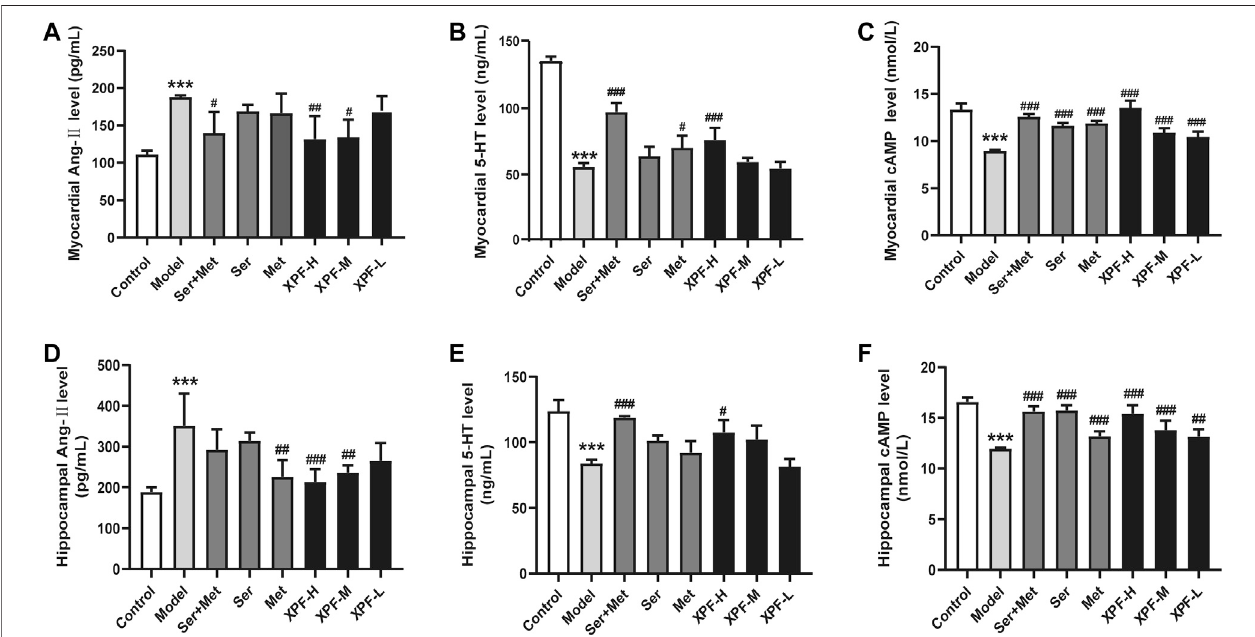
FIGURE 6 | Experimental validation of key targets Ang-II, 5-HT, cAMP in rat myocardium and hippocampus induced by CUMS and ISO. (A) The levels of Ang-II in themyocardialweredeterminedbyELISA. (B) Thelevelsof5-HTinthemyocardialweredeterminedbyELISA. (C) ThelevelsofcAMPinthemyocardialweredetermined byELISA. (D) ThelevelsofAng-IIinthehippocampus weredeterminedbyELISA. (E) Thelevelsof5-HTinthehippocampus weredetermined byELISA. (F) Thelevelsof cAMP in the hippocampus were determined by ELISA. Data were presented as means ± SD ( n (cid:2) 3). *** p < 0.005 compared with the control group, ## p < 0.05, ## p < 0.01, ### p <